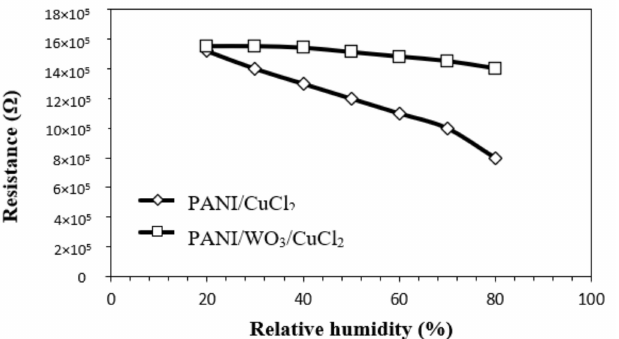
Figure 24. Change in resistance of PANI/CuCl 2 and PANI/WO 3 /CuCl 2 -based sensors with changing ambient relative humidity %.